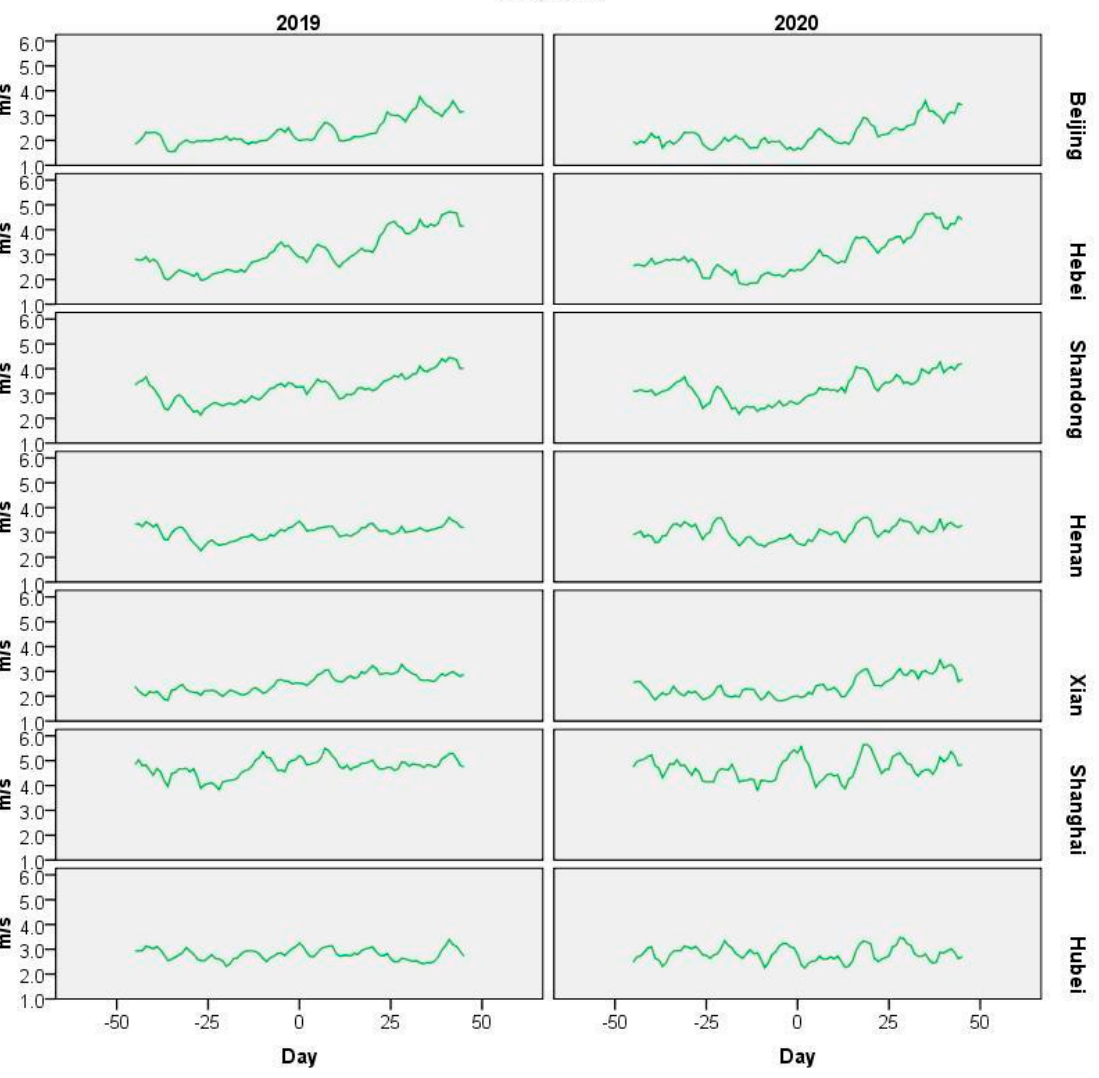
Figure A2. Daily time series of wind speed during equivalent 91-day timeframes of investigation for 2019 and 2020, across seven regions of China.